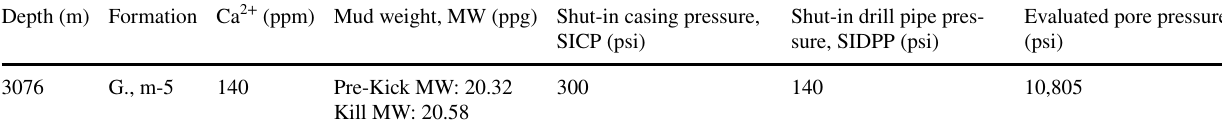
The shut-in casing pressure, SICP, and shut-in drill pipe pressure, SIDPP, were recorded. The real pore pressure magnitude has been evaluated by adding SIDPP to the old mud column pressure. This will be used to calibrate the pore